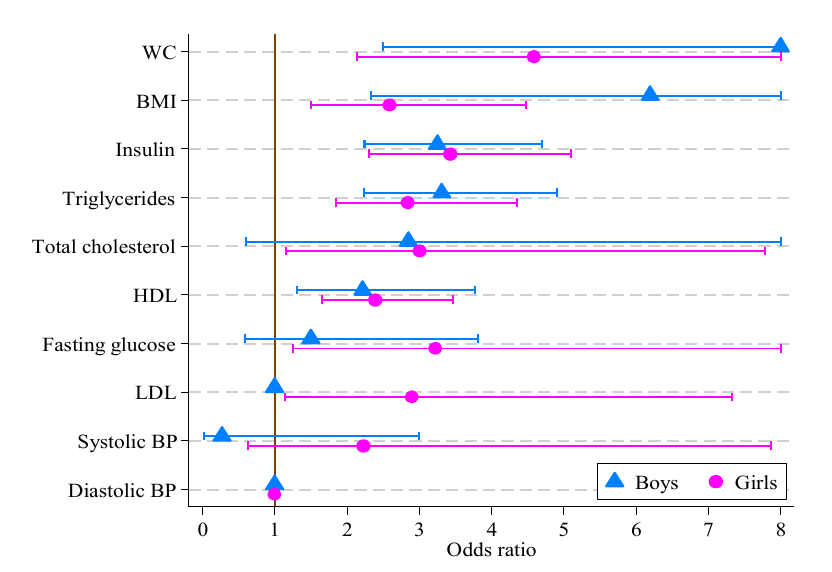
Figure 1. Odds ratios, with 95% confidence intervals, for boys and girls from multivariate logistic regression models of CVD risk score on individual CVD risk score factors (boys, n = 121; girls, n =